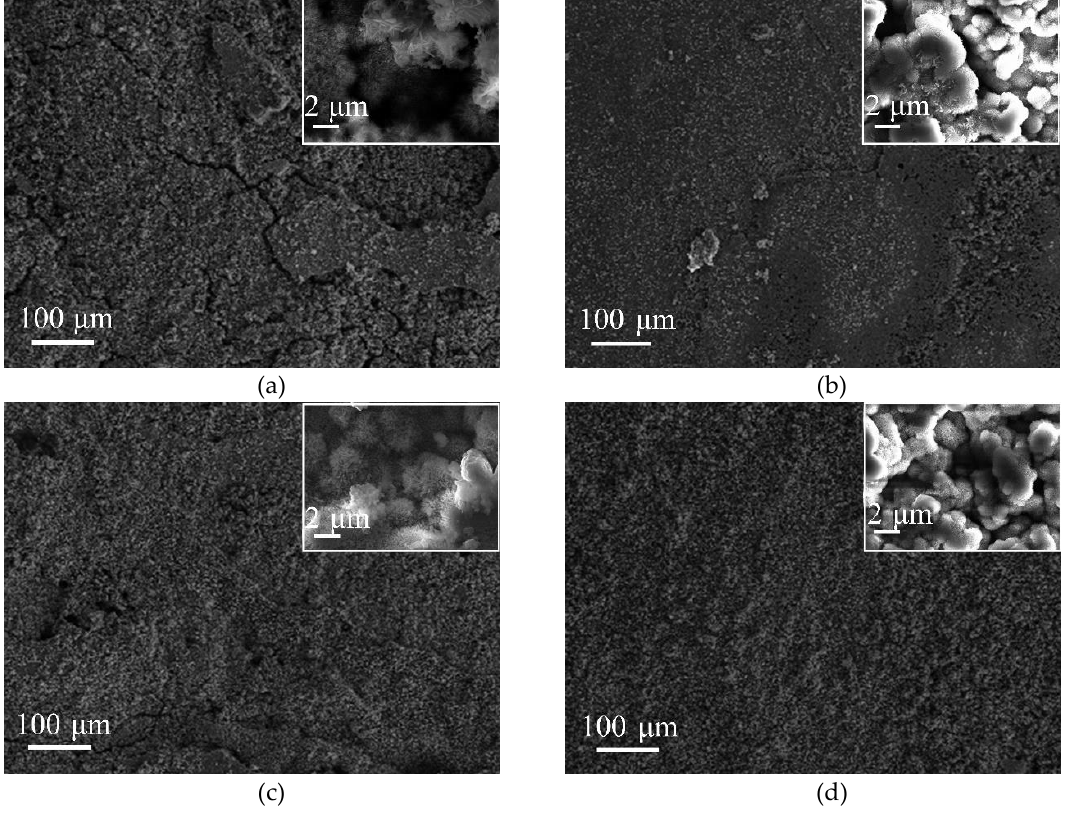
Figure 5. SEM micrographs of the surface rust layers of SMA490BW steel ( a ) 75 h, ( b ) 150 h, and welded joints ( c ) 75 h, ( d ) 150 h, after the periodic immersion wet/dry cyclic corrosion test.